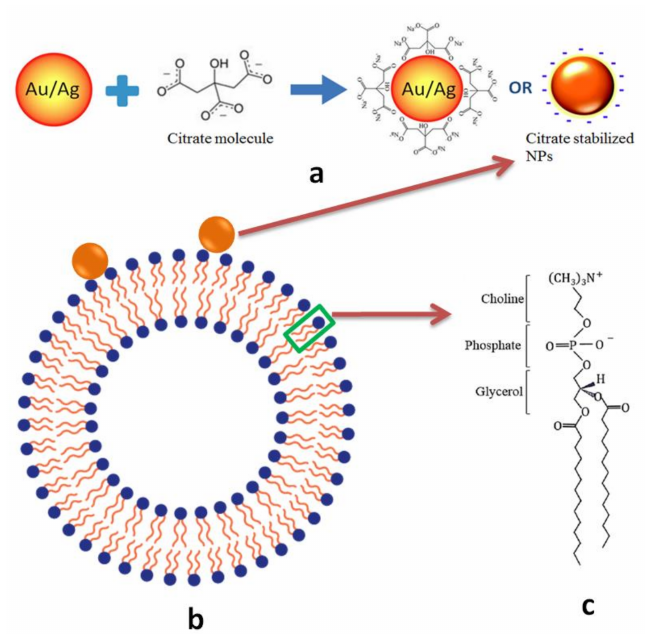
Figure 8. ( a ) Schematic of citrate stabilized NPs. ( b ) Schematic of a giant unilamellar vesicle (GUV) attached with a nanoparticle. ( c ) The molecular structure of